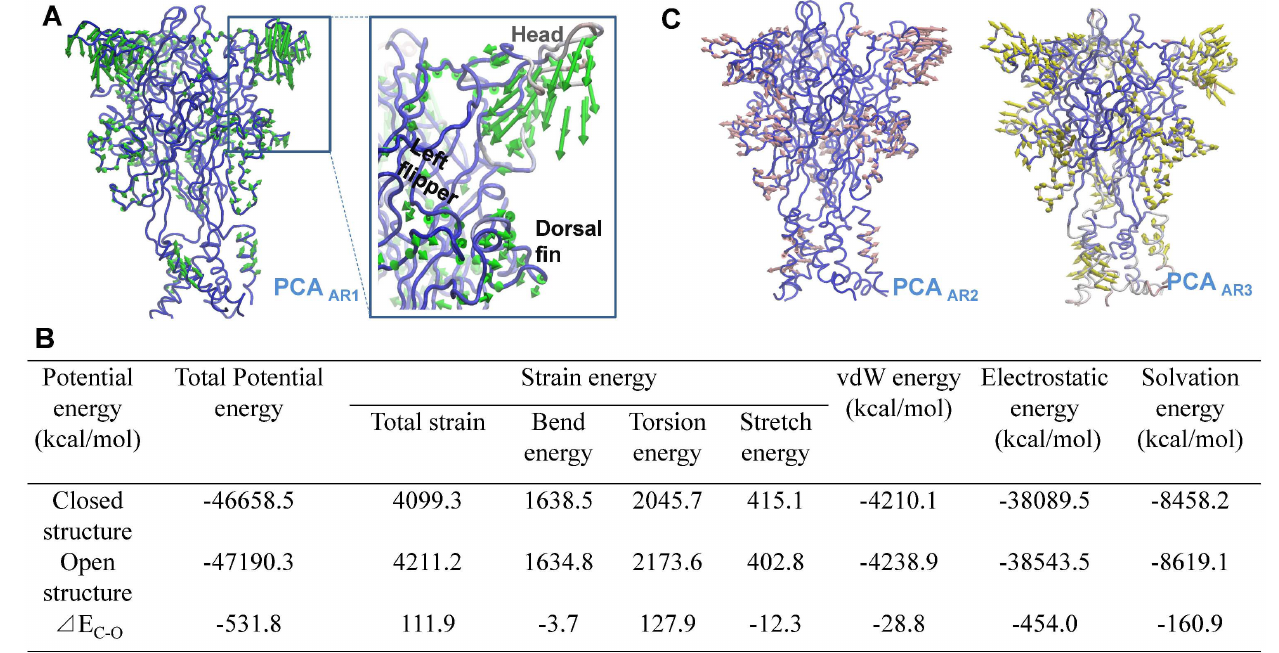
Figure 5. AR1’s occurrence-mediated ‘induced-fit’ allosteric changes in ABP and whole zf P2 X 4 receptor. ( A ) Vector representation of the motions of zfP2 X 4 (PDB entry code: 3H9V) in principal component analysis (PCA) based on the snapshots from 10-ns MD simulation of zfP2 X 4- ATP complex in AR1 mode. The vector arrows represent both the amplitudes and directions of the displacements experienced by residues during conformational changes. ( B ) Summary of the potential energy of receptors at the resting and open states. ( C ) Vector representation of the motions of zfP2 X 4 in PCA analysis based on the snapshots from 10-ns MD simulation of zfP2 X 4 complexes with pre-docked ATP based on AR2 and AR3 modes.